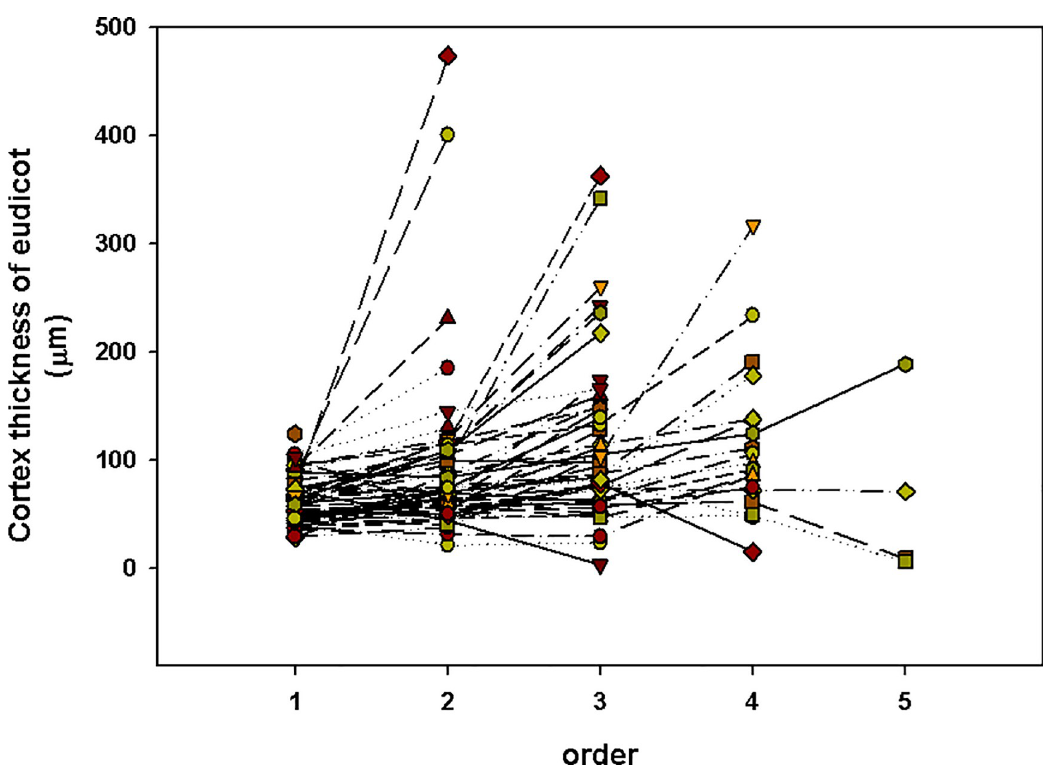
Fig 8. Cortex thickness of